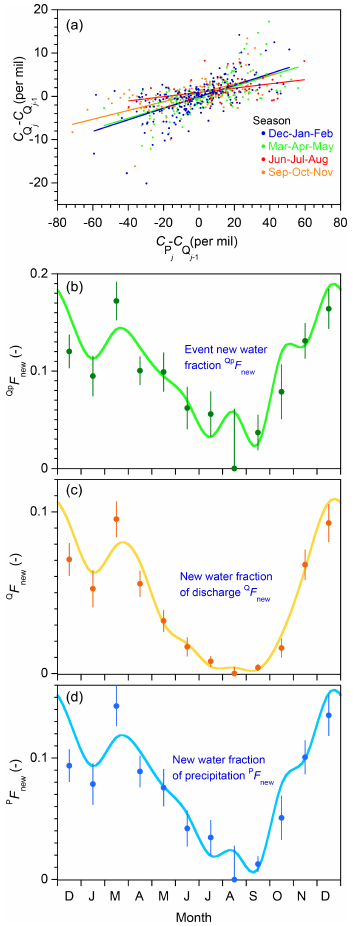
Figure 9. Seasonality in new water fractions under Mediterranean climate precipitation forcing. (a) Relationship between tracer con- centrations in precipitation and streamflow in the flashy benchmark model run shown in Fig. 1, stratified by season. Each season’s event new water fraction can be estimated from the slope of the regression line fitted to the corresponding set of points. (b, c, d) Average event new water fractions ( Q p F new ) , new water fractions of discharge ( Q F new ) , and forward new water fractions of precipitation ( P F new ) calculated from ensembles of all points within each month, across the 5 years of benchmark model simulations. Error bars show stan- dard errors, where these are larger than the plotting symbols. Curves are drawn through true monthly average new water fractions, as de- termined by age tracking in the benchmark model. Ensemble hy- drograph separation reproduces this seasonal pattern in new water fractions reasonably well. The uncertainty estimates also realisti- cally predict the average deviation of the ensemble hydrograph sep- aration estimates from the true age-tracking determinations. Values shown here are generated by the benchmark model with the flashy catchment parameter set and Smith River (Mediterranean climate) precipitation forcing. The new water fractions would exhibit less pronounced seasonality if the rainfall forcing were less strongly sea- sonal or the catchment response were less